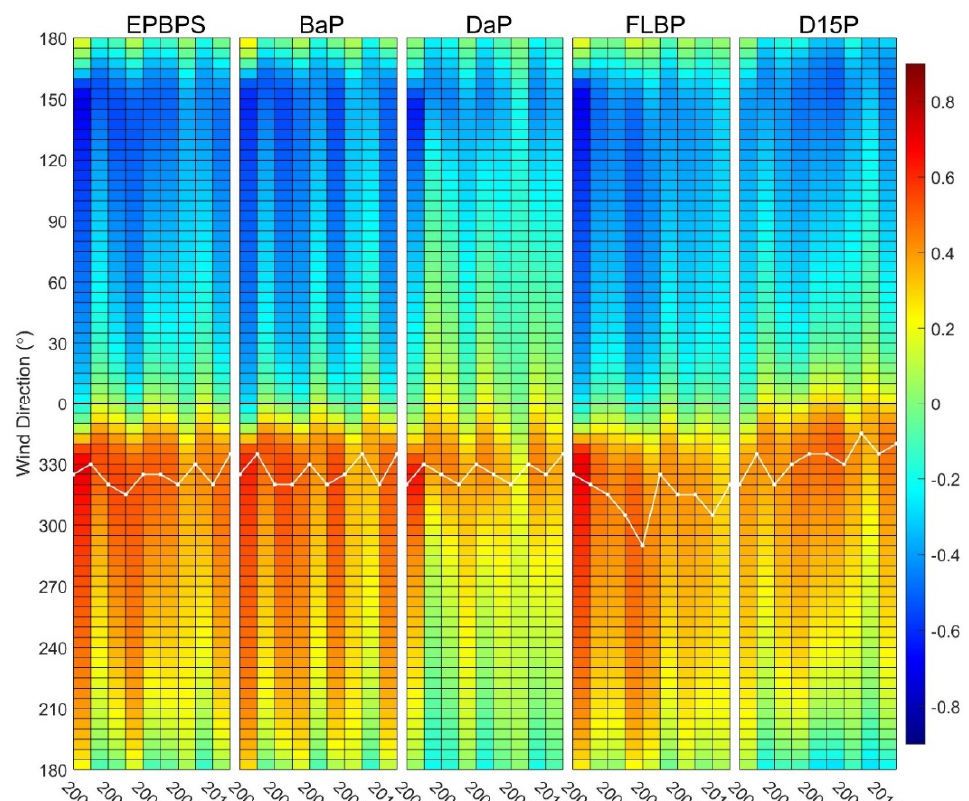
Figure 6. The correlation coefficients for the direction of the wind components and polynya area in different years. The directions of the wind components with the maximum correlation coefficient for each year are indicated by the white dots connected by the white lines. Each column is labelled with the abbreviation of the polynya it refers to.